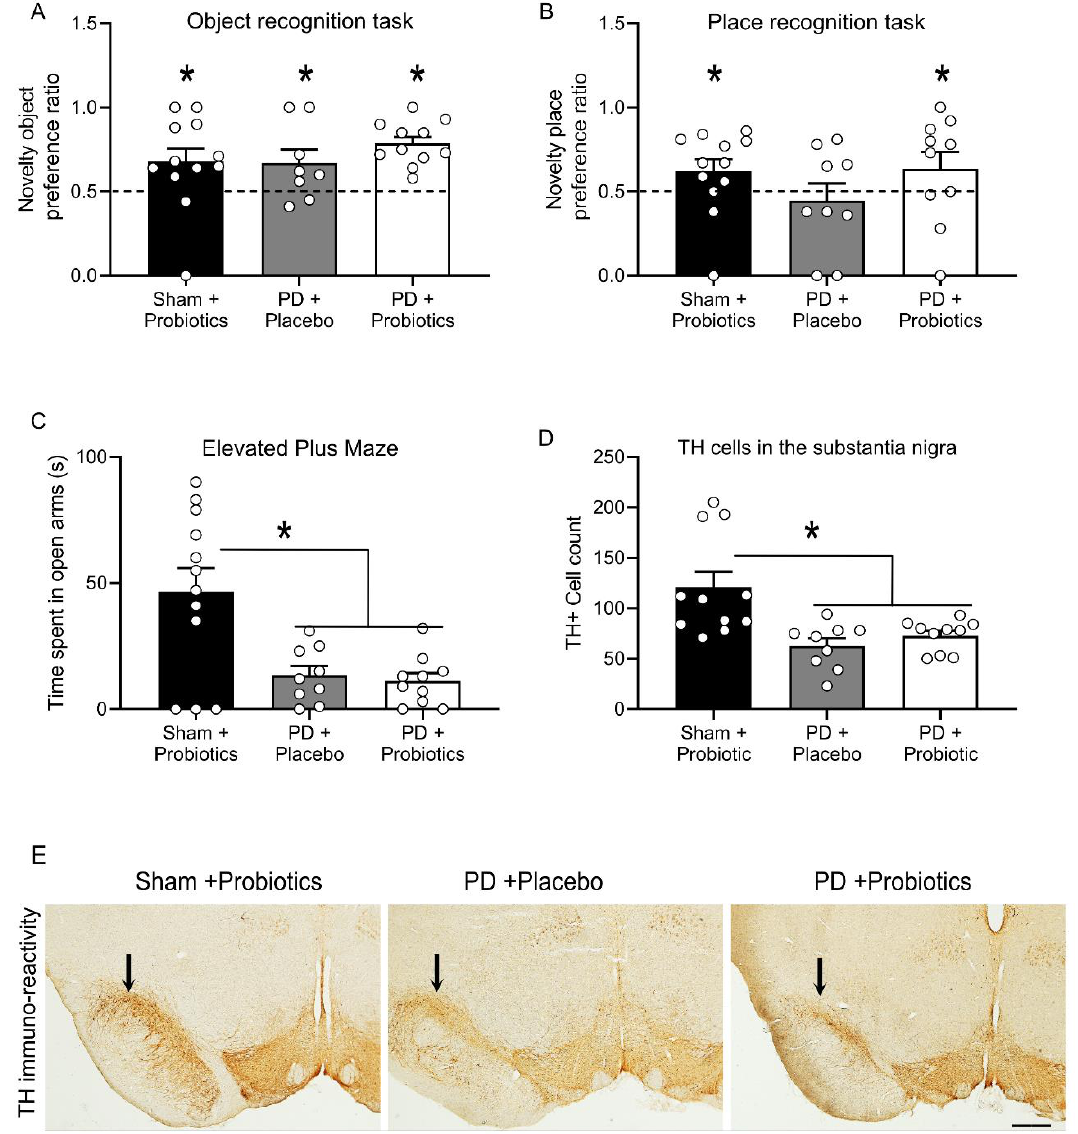
Figure 2. Performance on the novel object and novel place tasks, where the novelty preference ratio for the object and place tasks are depicted in panels ( A ) and ( B ) (respectively). “*” indicates retention ratios larger than 0.5, demonstrating memory retention of the familiar object/place, indicated by the dashed line set at 0.5. ( C ) Time, in seconds, spent in the open arms of the elevated plus maze (mean ± SEM). There was significant difference between sham and Parkinson’s disease (PD) groups, indicating greater anxiety in the PD groups; the “#” indicates p = 0.001. There was no difference between the two PD groups, p = 0.973. ( D ) Graph showing the tyrosine hydroxylase (TH) immunoreactive neuronal count between groups. There were significantly less dopamine neurons in the PD groups compared to sham group. “*” indicates p = 0.001. There was no difference between the two PD groups, p = 0.801. ( E ) Representative images of immunohistochemical stain of tyrosine hydroxylase in the substantia nigra. Arrows above substantia nigra indicate region of dopamine loss. Images taken 10×, scale bar = 100 microns.